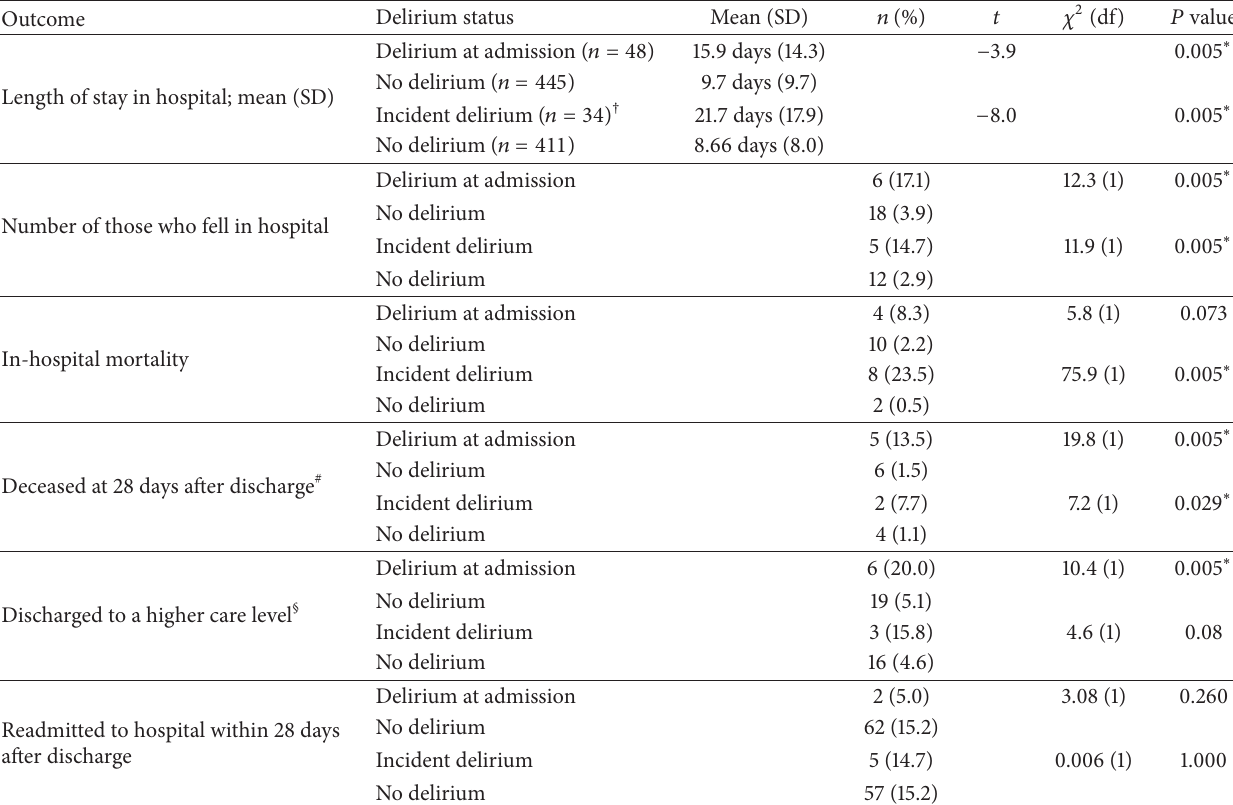
Table 2: Outcomes of patients with and without delirium at or during the